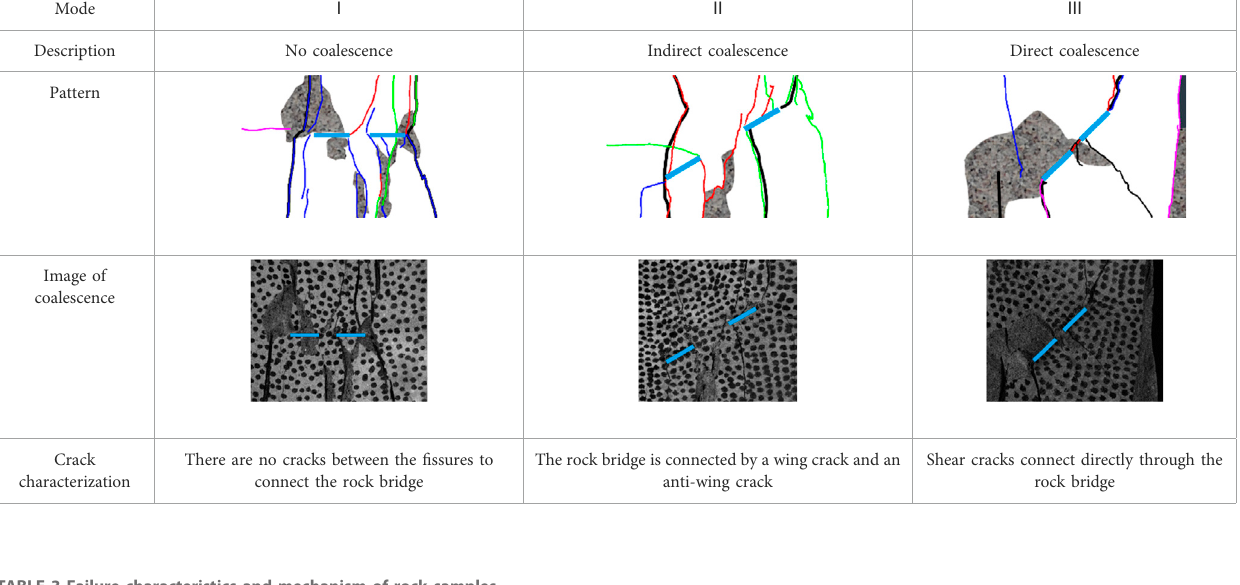
TABLE 3 Failure characteristics and mechanism of rock